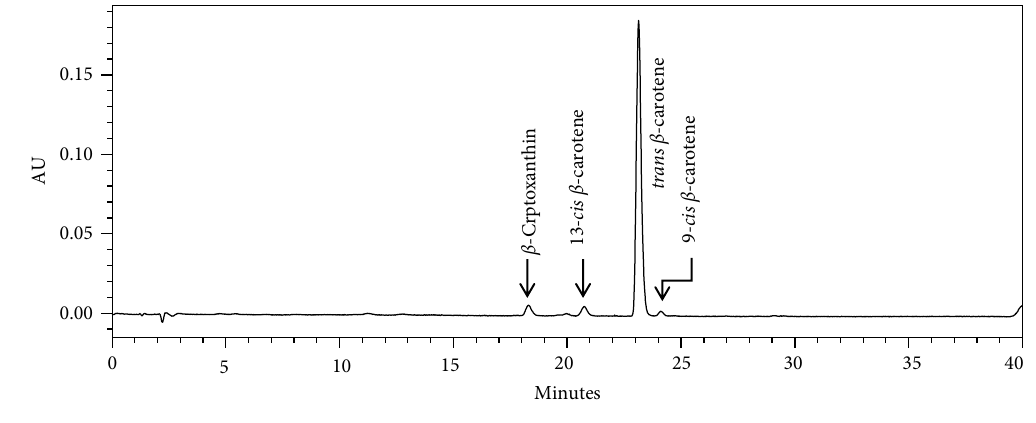
Figure 3: β -Carotene chromatogram for sweet potato roots.